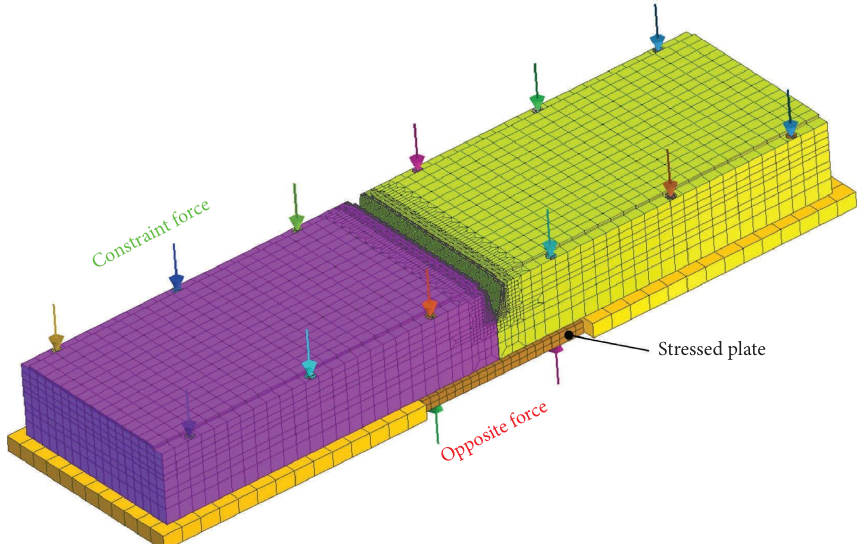
Figure 3: Te state of force on the antenna’s azimuth track.